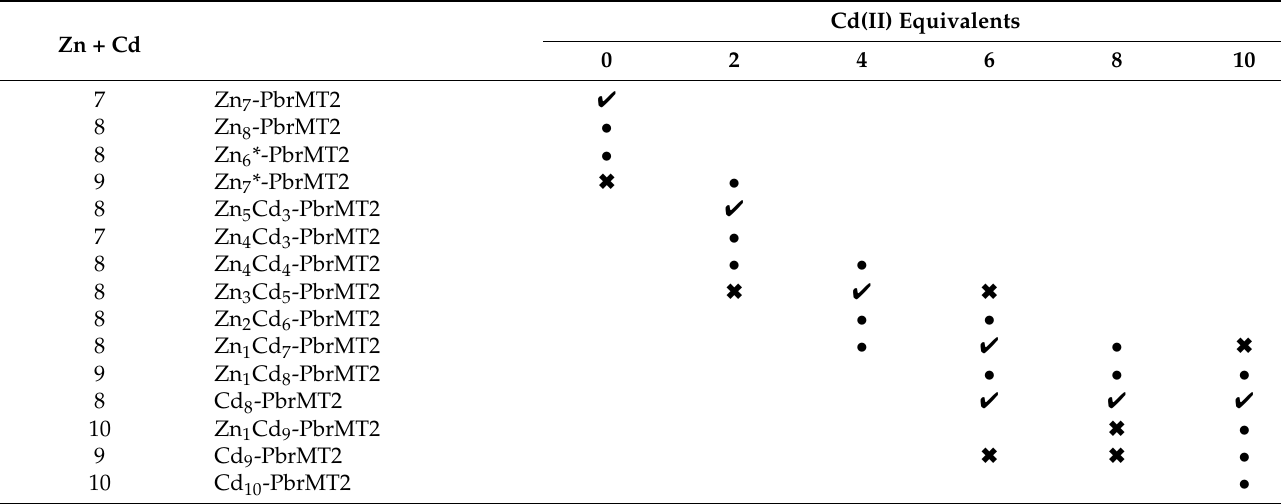
Table 3. Species detected by ESI-MS during the addition of Cd(II) to the Zn-PbrMT2 preparation at pH 7.0. The correspond- ing ESI-MS spectra are shown in Figure